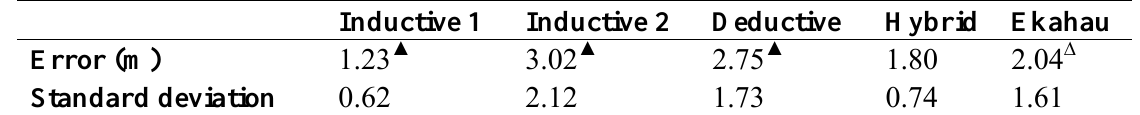
Table 2. Average errors and standard deviation to the surveyed